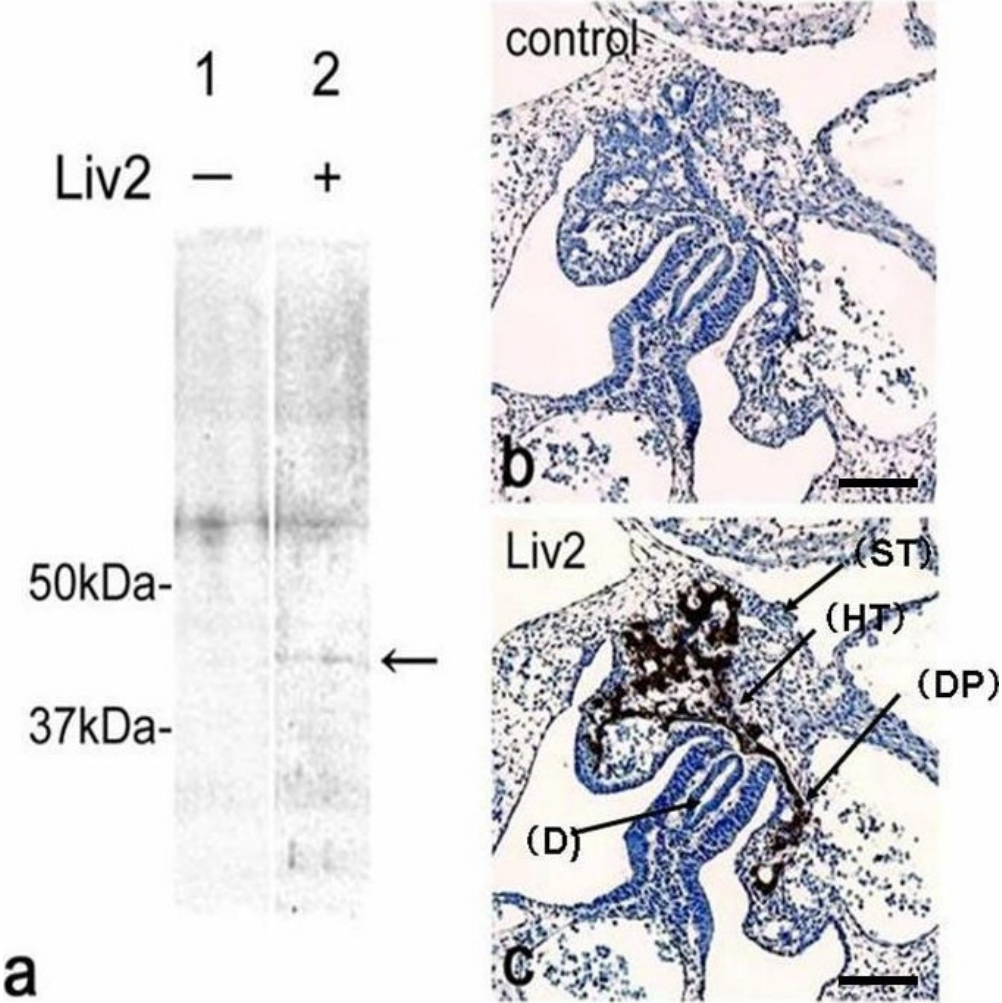
FIGURE 1. (a) Specificity of Liv2. Western blotting analysis of Liv2 using E11.5 embryonic liver. Lane 1 was negative control, omitting the step of primary antibody, and lane 2 was positive control. The target signal was observed at the estimated molecular weight of 40–45 kDa (lane 2, arrow). The signals of > 50 kDa and < 37 kDa were mouse IgG heavy chain and light chain, respectively. Immunohistochemical analysis of E9.5 embryo (b and c) was a section of E9.5 embryo omitting the step of primary antibody. Only immature hepatocytes were immunoreactive for Liv2 (c). D, duodenum; DP, dorsal pancreas; HT, hepatic trabeculae; ST, septum transversum. Bars = 100 µ